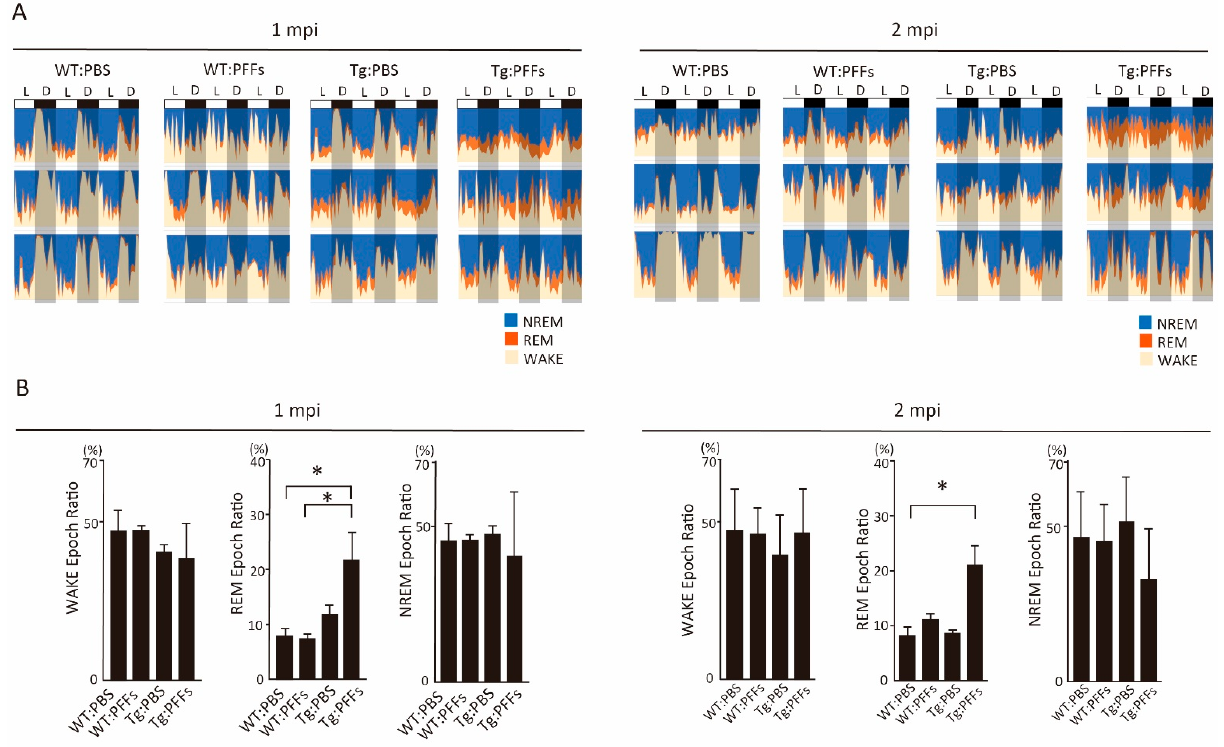
Figure 1. Sleep characteristics in intrastriatal α -syn preformed fibrils (PFFs)-inoculated A53T- SNCA BAC-Tg (Tg:PFFs) mice. ( A ) Sleep stage during every 12 h in light (L, ZT:8-20) and dark (D, ZT:20-8) phase at 1-month post inoculation (mpi) (left panel) or 2 mpi (right panel) among four groups of mice: phosphate-buffered saline (PBS)-inoculated wild-type (WT) mouse (WT:PBS), α -syn PFFs-inoculated WT mice (WT:PFFs), PBS-inoculated A53T transgenic mice (Tg:PBS), and α -syn PFFs-inoculated A53T-SNCA BAC-Tg (Tg:PFFs). The percentage of sleep stage per an hour was calculated and plotted into a timetable in the colored style. NREM: non-rapid eye movement (REM) sleep (blue), REM: REM sleep (orange), WAKE: wake (yellow). ( B ) The ratio of the number of every epoch (WAKE, REM, or NREM) to total epochs in the sleep stage at 1 mpi (left panel) or 2 mpi (right panel) among four groups of mice. Data were analyzed using a one-way ANOVA and multiple comparisons were analyzed with the Tukey–Kramer test ( n = 4 per group). Asterisks indicate a significant difference. Bar indicates the